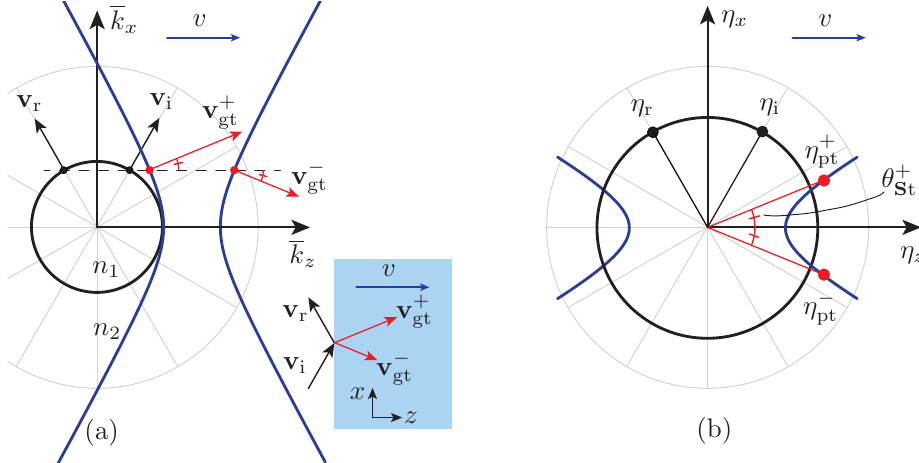
Figure 7. Same as Figure 6, but for the interluminal regime, with v = 0.9 c